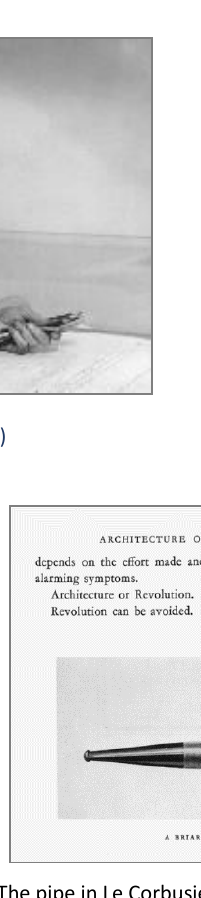
Figure 6 The pipe in Le Corbusier’s book, (Le Corbusier, 1970)